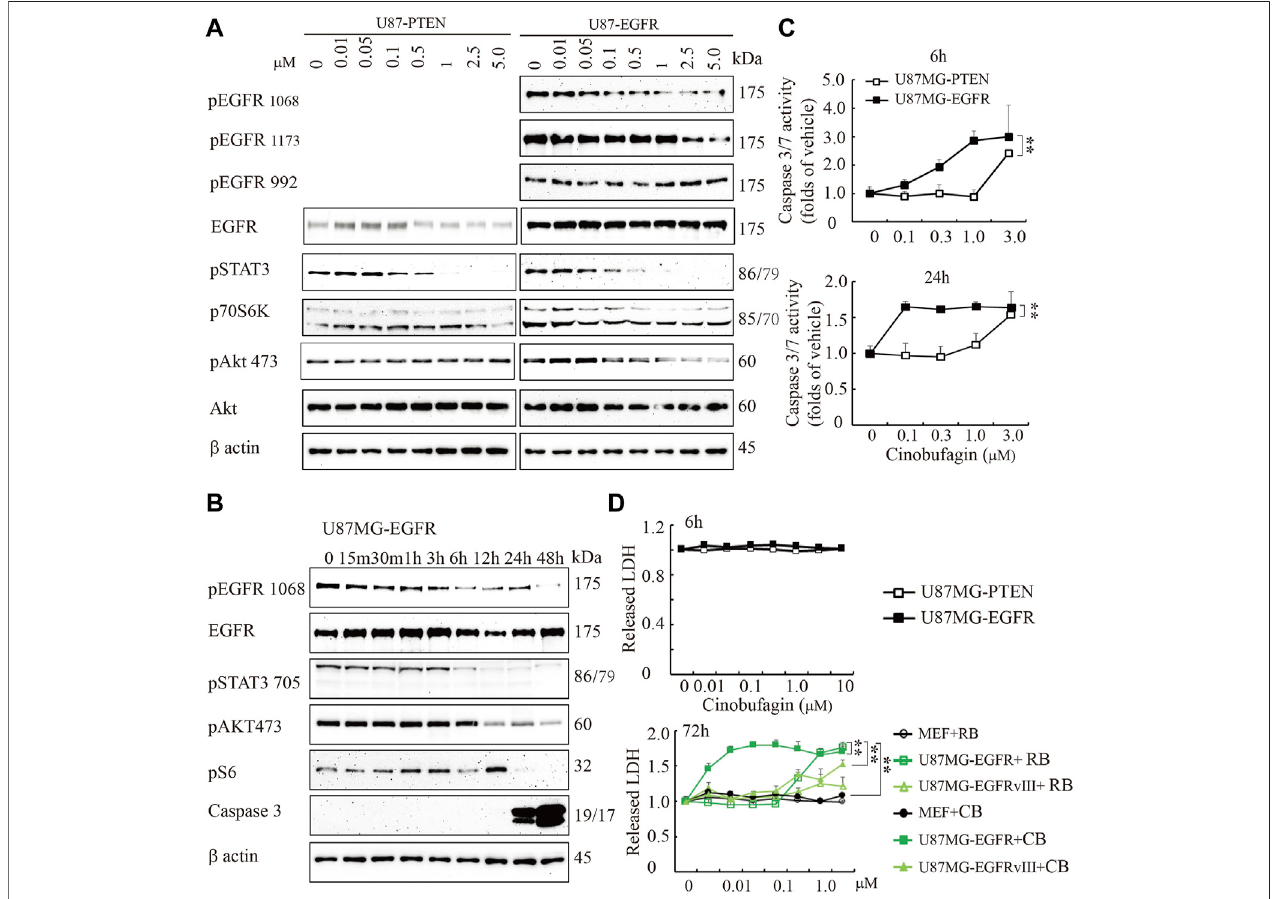
FIGURE 2 | Cinobufagin blocks EGFR phosphorylation and induces cell apoptosis and cytotoxicity. (A) Cinobufagin blocks EGFR signaling in a dose-dependent manner. Western blot analysis of U87MG-EGFR and U87MG-PTEN cells treated with different concentrations of cinobufagin for 6 h. Blots are representative of three experiments. (B) Cinobufagin blocks EGFR signaling in a time-dependent manner. Western blot analysis of U87MG-EGFR cells treated with 0.5 μ M cinobufagin for different times as indicated. Blots are representative of three experiments. (C) Cinobufagin speci fi cally induces apoptosis in U87MG-EGFR cells. The cells treated with a range of doses of cinobufagin for 6 or 24 h, then the caspase 3/7 activity was measured with Caspase-Glo 3/7 Assay. (D) Cinobufagin speci fi cally induces cytotoxicity of U87MG-EGFR cells. The cells were treated with different doses of cinobufagin (CB) or resibufogenin (RB) for 6 or 72 h, then the released LDH were measured with cytoTox 96 Non-radioactive Cytotoxicity Assay. Data are means ± SD.